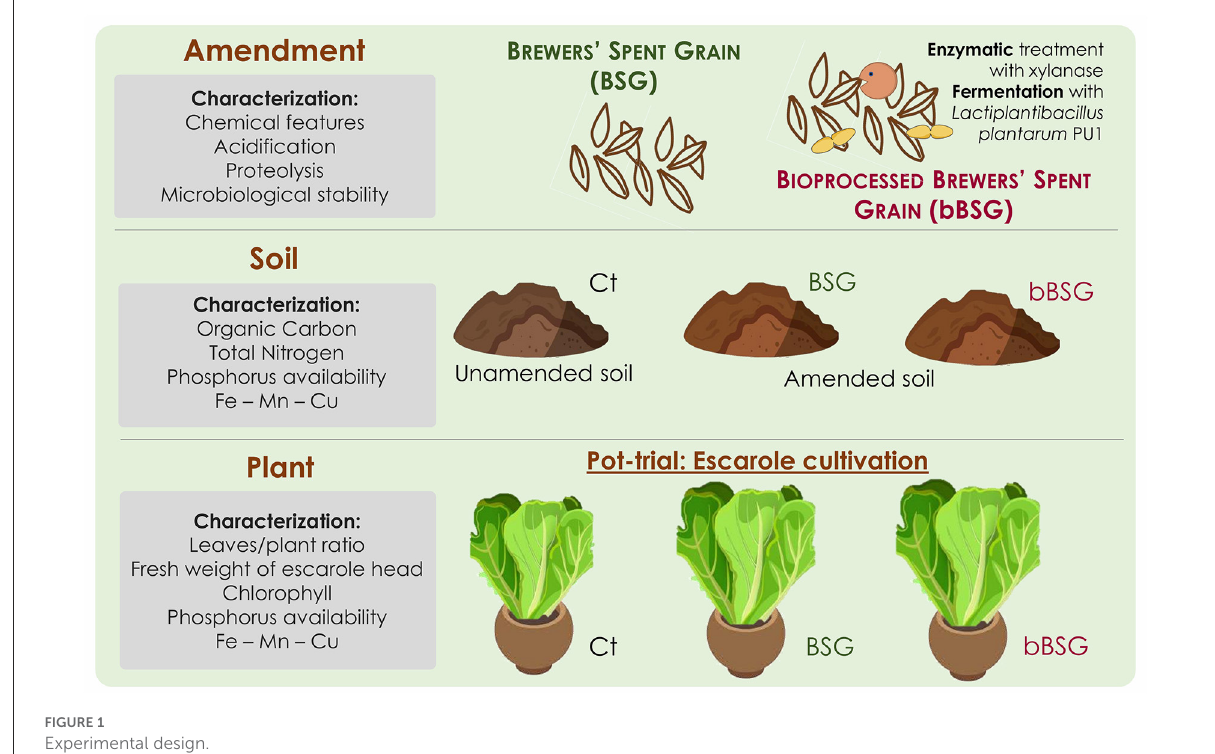
FIGURE1 Experimental